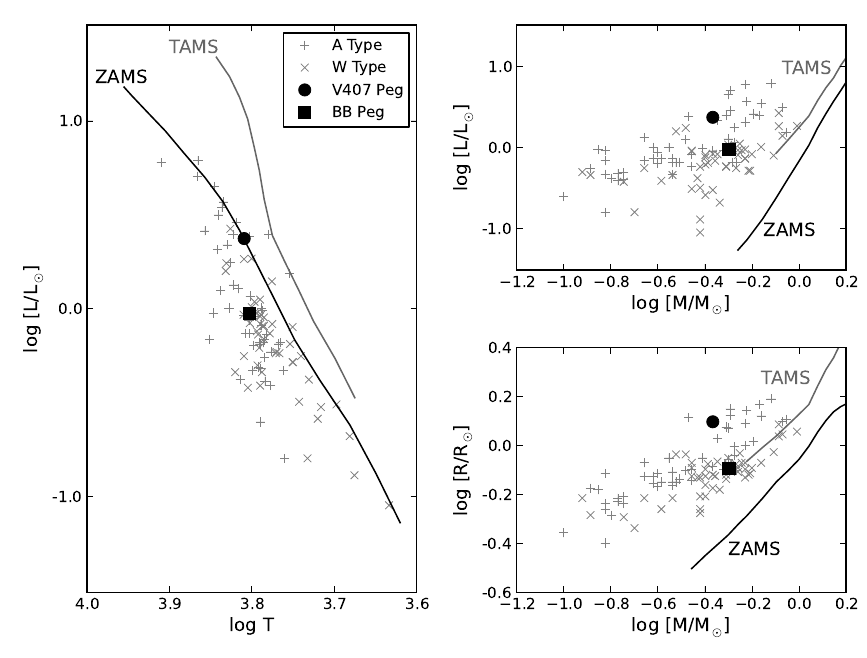
Fig. 7. HRD (left), mass-luminosity (top right) and mass-radius (bottom right) dia- grams of selected W UMa secondaries and the secondary components of our targets. The rest is the same as in Figure